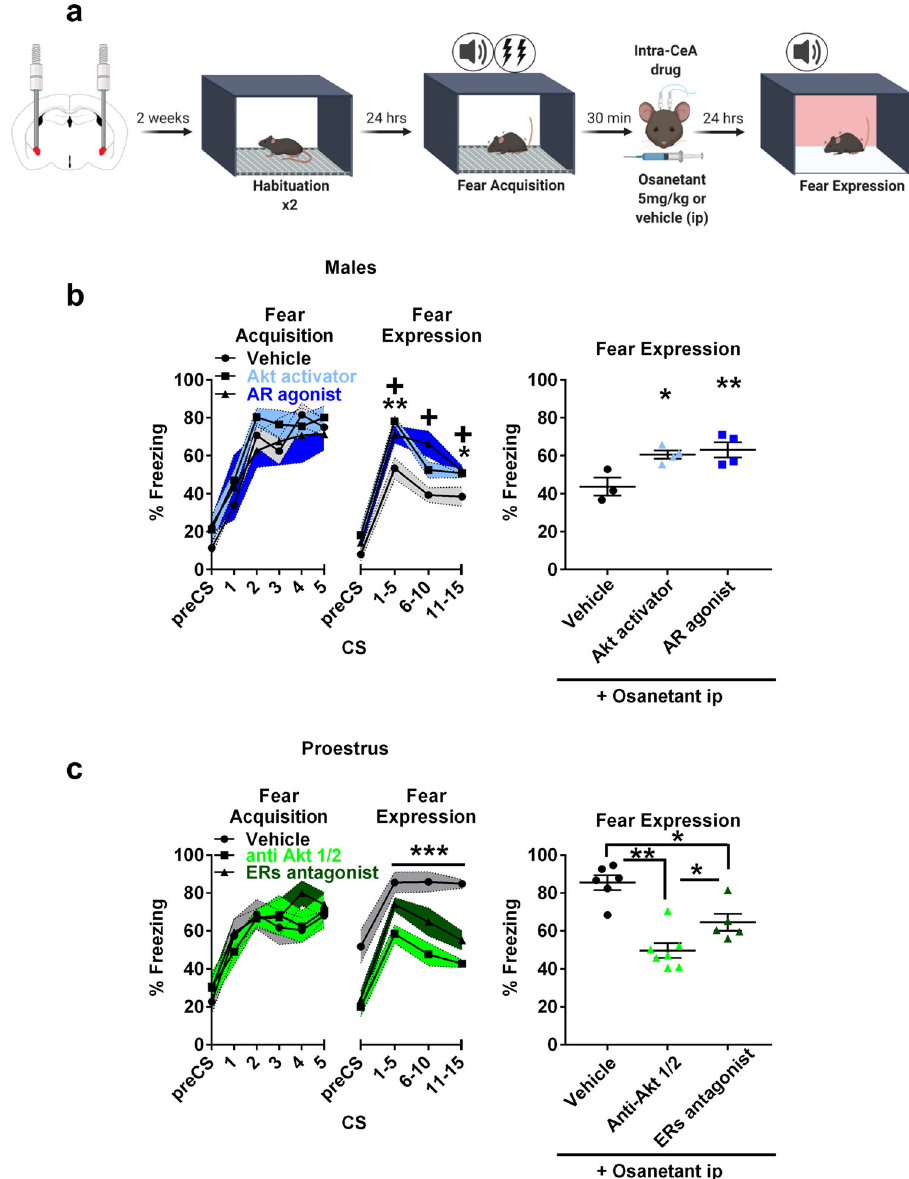
Fig. 6 Downregulation of CeA-Akt pathway and testosterone in males and upregulation of CeA-Akt signaling and estradiol in proestrous females are necessary for the systemic effect of osanetant in memory. a Schematic procedure for intra-CeA infusion of drugs after Fear Acquisition (FA). All mice received osanetant ip. Males received intra-CeA Akt activator, Androgen Receptor (AR) agonist or vehicle. Females received intra-CeA Akt inhibitor, Estrogen Receptors (ERs) antagonist or vehicle. b Effect of an acute administration of an Akt activator or an AR agonist in osanetant treated adult males on fear memory consolidation (vehicle n = 3; Akt activator n = 4; androgen receptor agonist n = 4) (against vehicle: Akt activator p = 0.013; AR agonist: p = 0.006). * p ≤ 0.05 ** p ≤ 0.01 *** p ≤ 0.001 indicate Akt activator vs. vehicle and + p ≤ 0.05 indicates AR agonist after decomposition of the CSxTreatment interaction. c Effect of an acute administration of an anti-Akt drug or ERs agonist after FA on fear memory consolidation in osanetant treated proestrus females (vehicle: n = 6; anti- Akt: n = 7; ERs antagonist n = 5) (against vehicle: anti-Akt p = 0.000; ERs antagonist p = 0.003). * p ≤ 0.05 ** p ≤ 0.01 *** p ≤ 0.001 indicate main treatment effect in repeated measures ANOVA and pairwise comparisons. Data are mean±SEM. Main effect treatment, main effect CS, and CSxTreatment interaction were analyzed using repeated measures ANOVA. Two-tailed pairwise comparisons are indicated for ( b ) and ( c